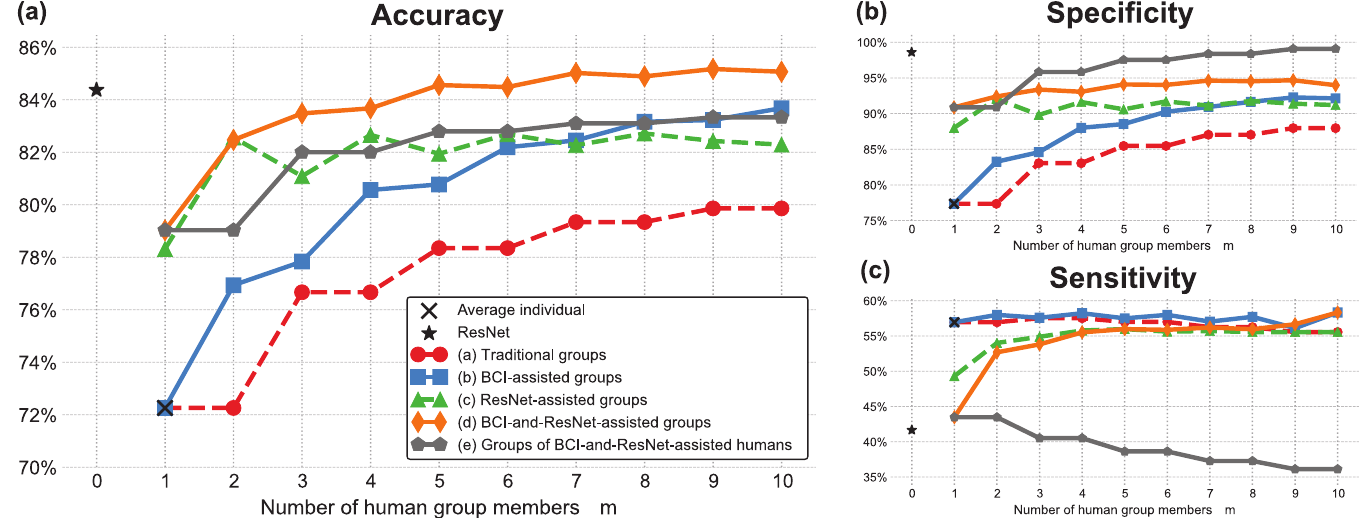
Fig 5. Average performance of individuals, ResNet, and groups of increasing size making decisions using the approaches described in Fig 3. (a) Accuracy. (b) Specificity (true negative rate). (c) Sensitivity (true positive rate).